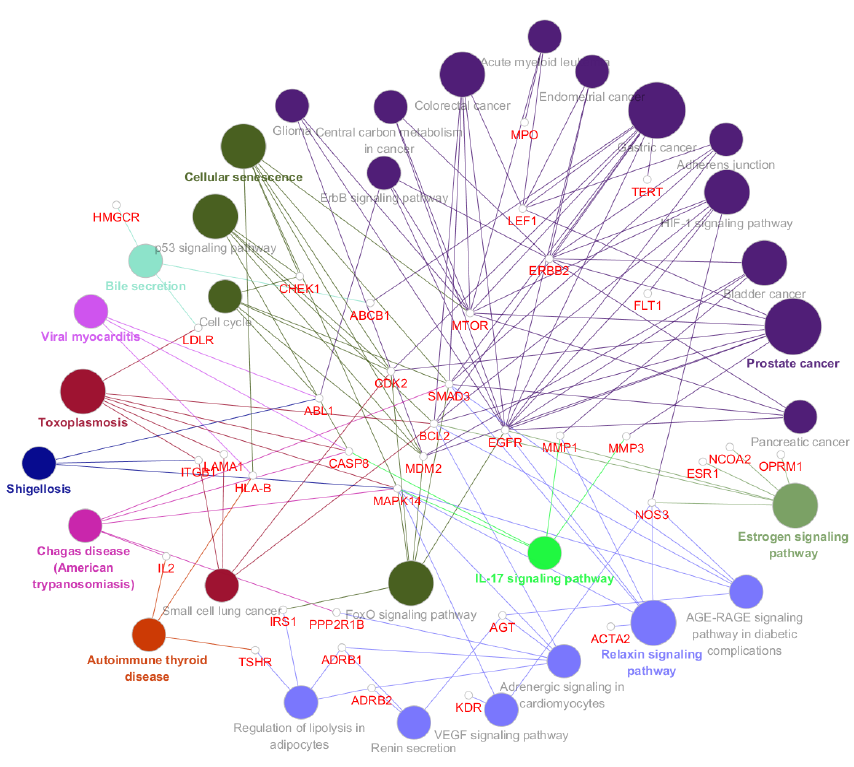
Figure 4. Target-pathway network. Small nodes stand for therapeutic targets for lung cancer. Large nodes stand for main pathways based on enrichment analysis.